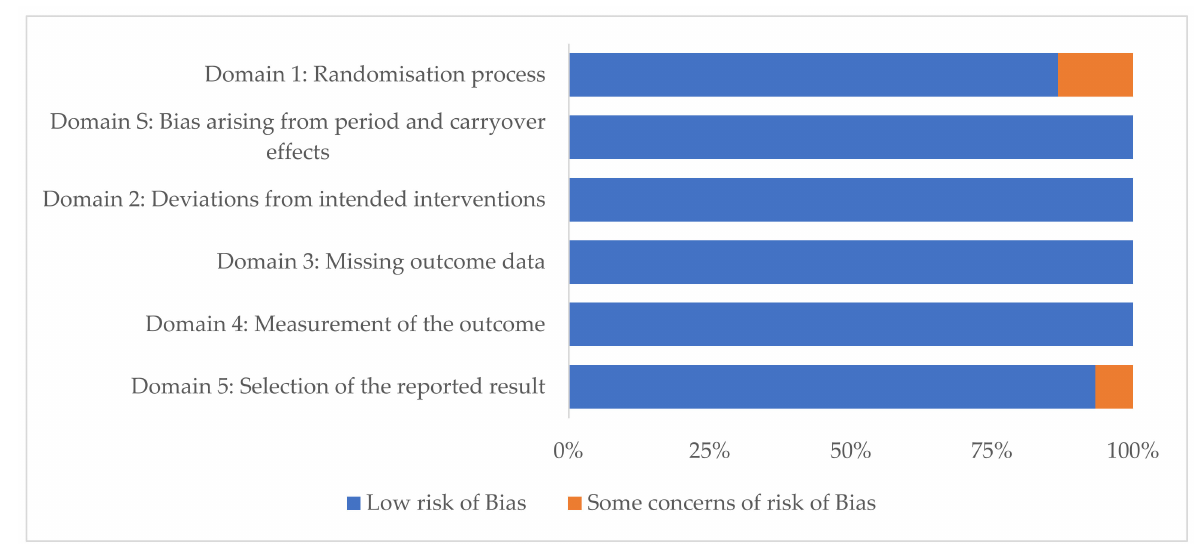
Figure 2. Within-study risk of bias assessment using the revised Cochrane risk-of-bias tool (RoB2) in 15 randomised ( n = 11) and non-randomised ( n = 2) controlled cross-over trials examining health outcomes of lupin consumption.